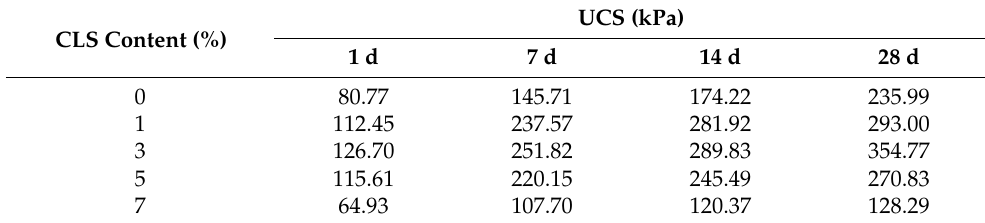
Table 4. UCS of improved loess under different CLS content and curing age.